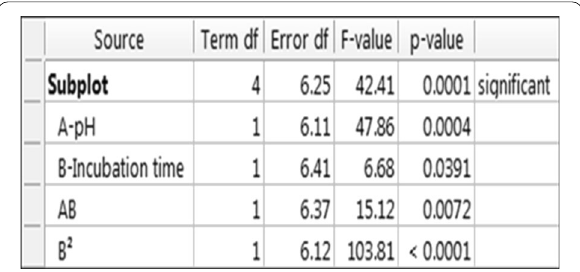
Fig. 5 the analysis of variance ANOVA in biosurfactant production by kocuria rosea